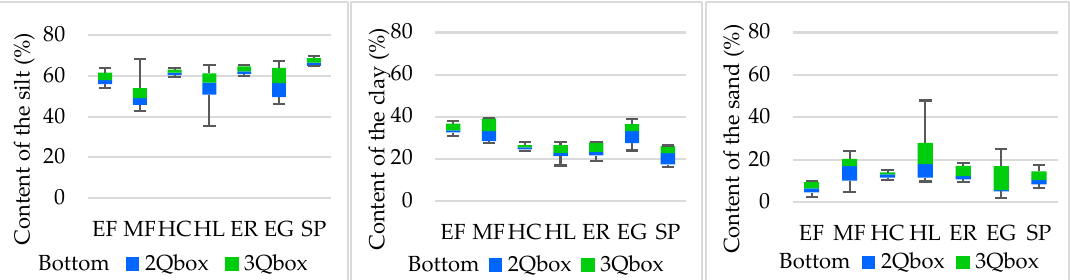
Figure 1. Differences in particle size fractions; EF: Eutric Fluvisol; MF: Mollic Fluvisol; HC: Haplic Chernozem; HL: Haplic Luvisol; ER: Eutric Regosol; EG: Eutric Gleysol; SP: Stagnic Planosol. Error bars represent maximum and minimum values.